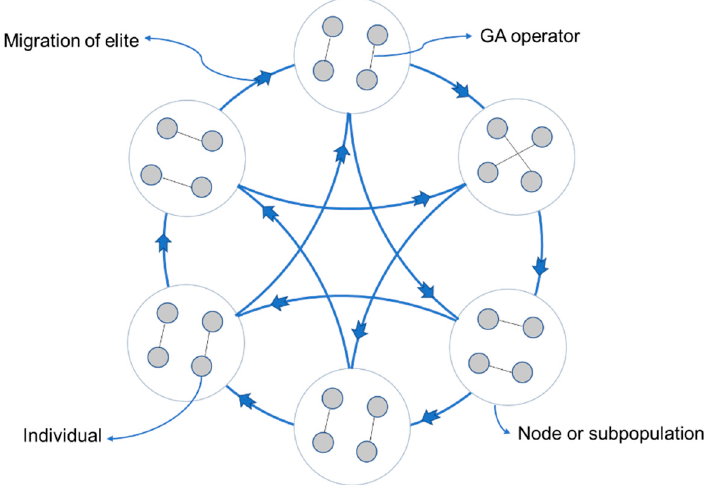
Figure 5. Schematic diagram of migration within the ring-shaped